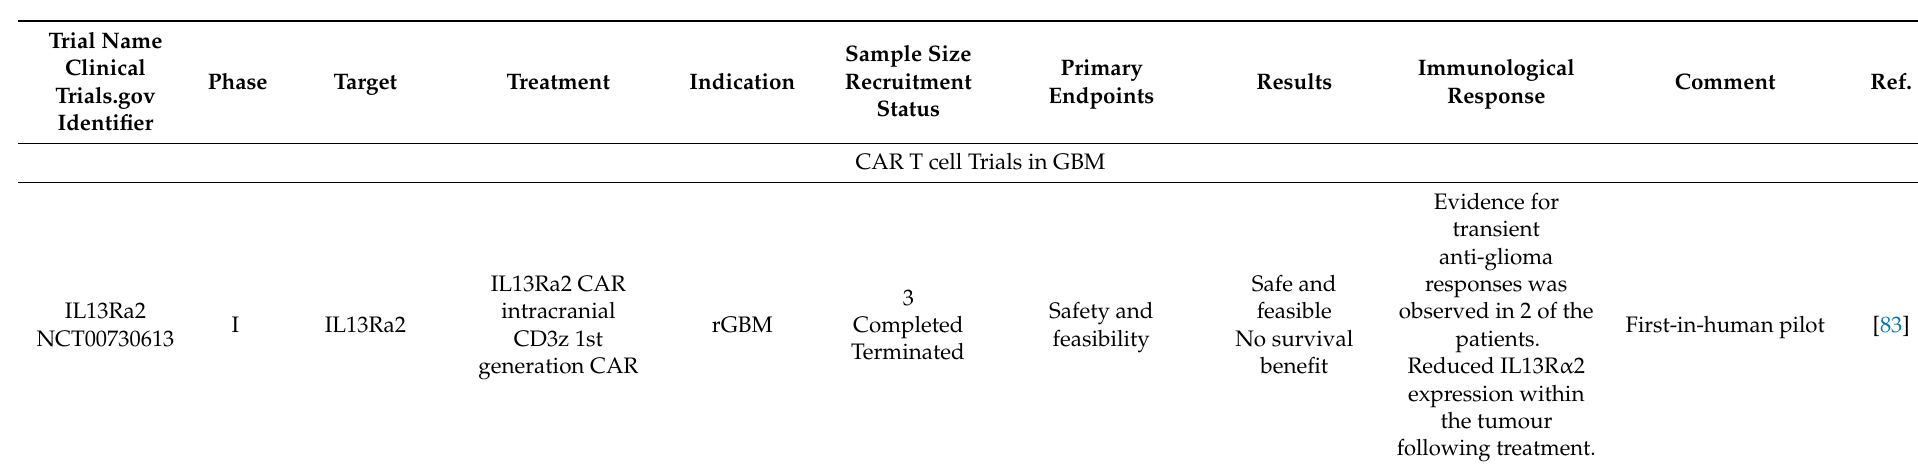
Table 3. Overview of the CAR clinical trials in